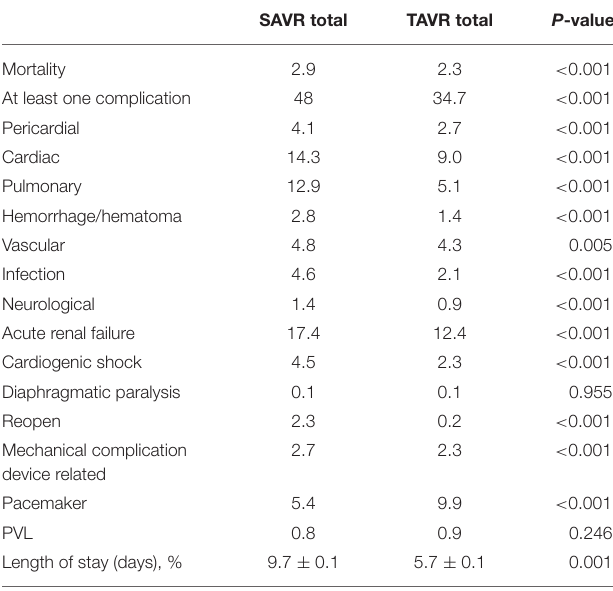
TABLE 2 | Comparison of mortality and complications of SAVR vs. TAVR during the years 2011–2017. SAVR total TAVR